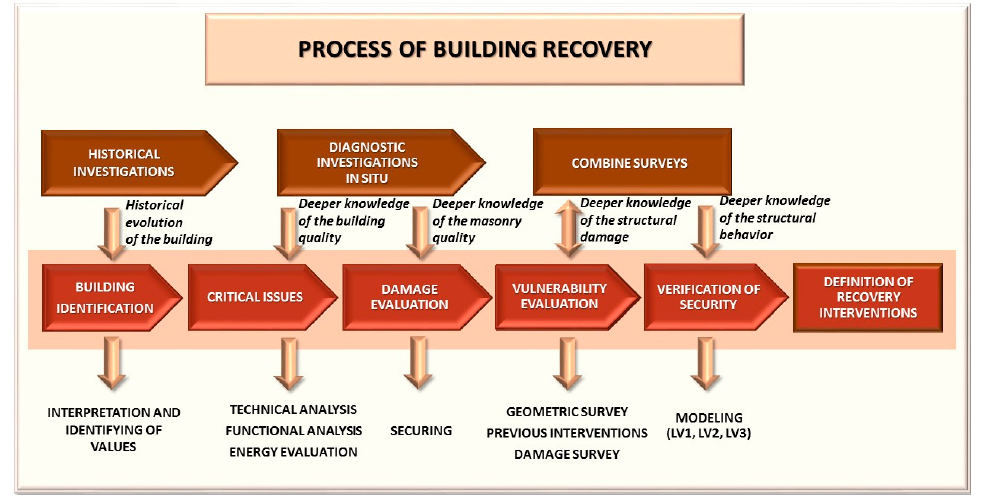
Figure 1. The methodological process and identification of the level of knowledge of a historical building. The multi-disciplinary approach is highlighted in brown and it is developed during design and construction phases as an underlying support for the whole design process.